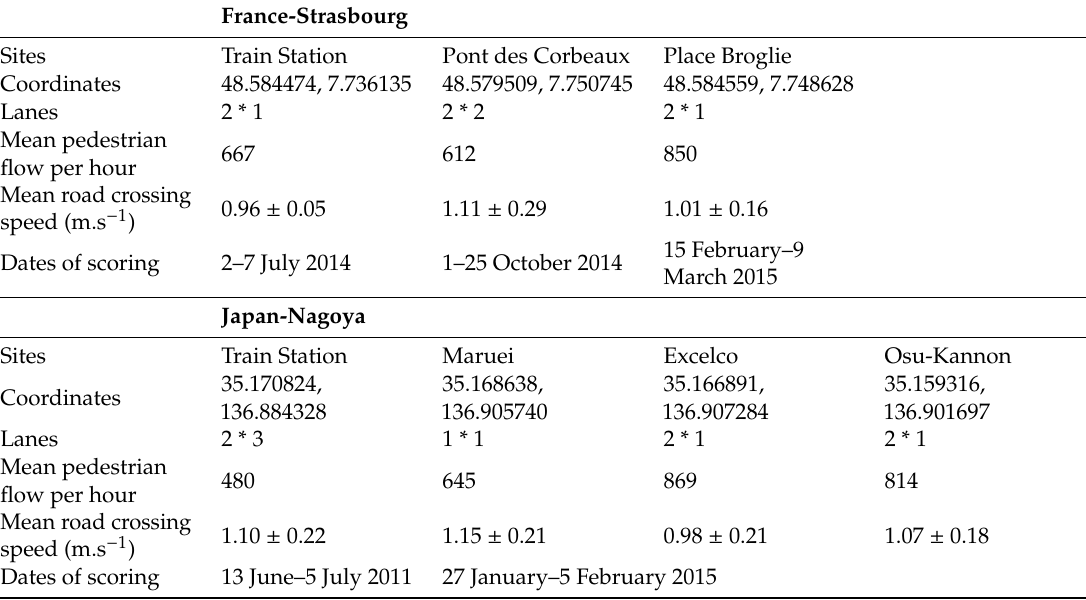
Table 1. Information about the studied sites in France and in Japan. Road-crossing speed was estimated by scoring the crossing speed of 20 random pedestrians for each